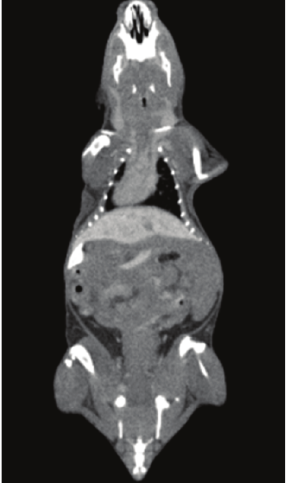
Figure 12: Mouse image enhanced by Fenestra